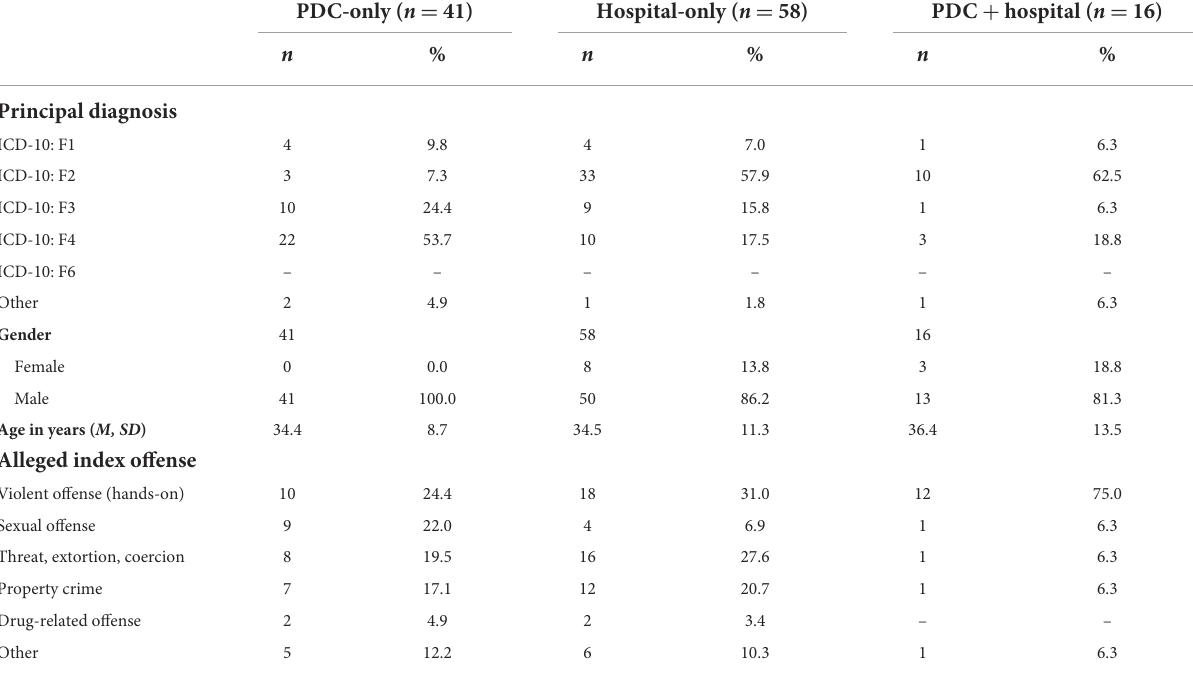
TABLE 5 Characteristics of individuals in Zurich’s pre-trial detention centers treated in clinical settings between 1st July 2019 and 31st December 2020 ( N = 115). PDC-only ( n = 41) Hospital-only ( n =